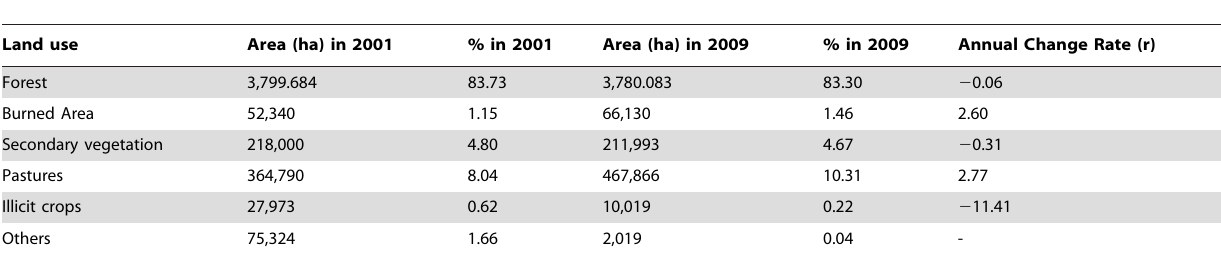
Table 1. Land uses in 2001 and 2009 (ha and %) and change rate for the entire study area.